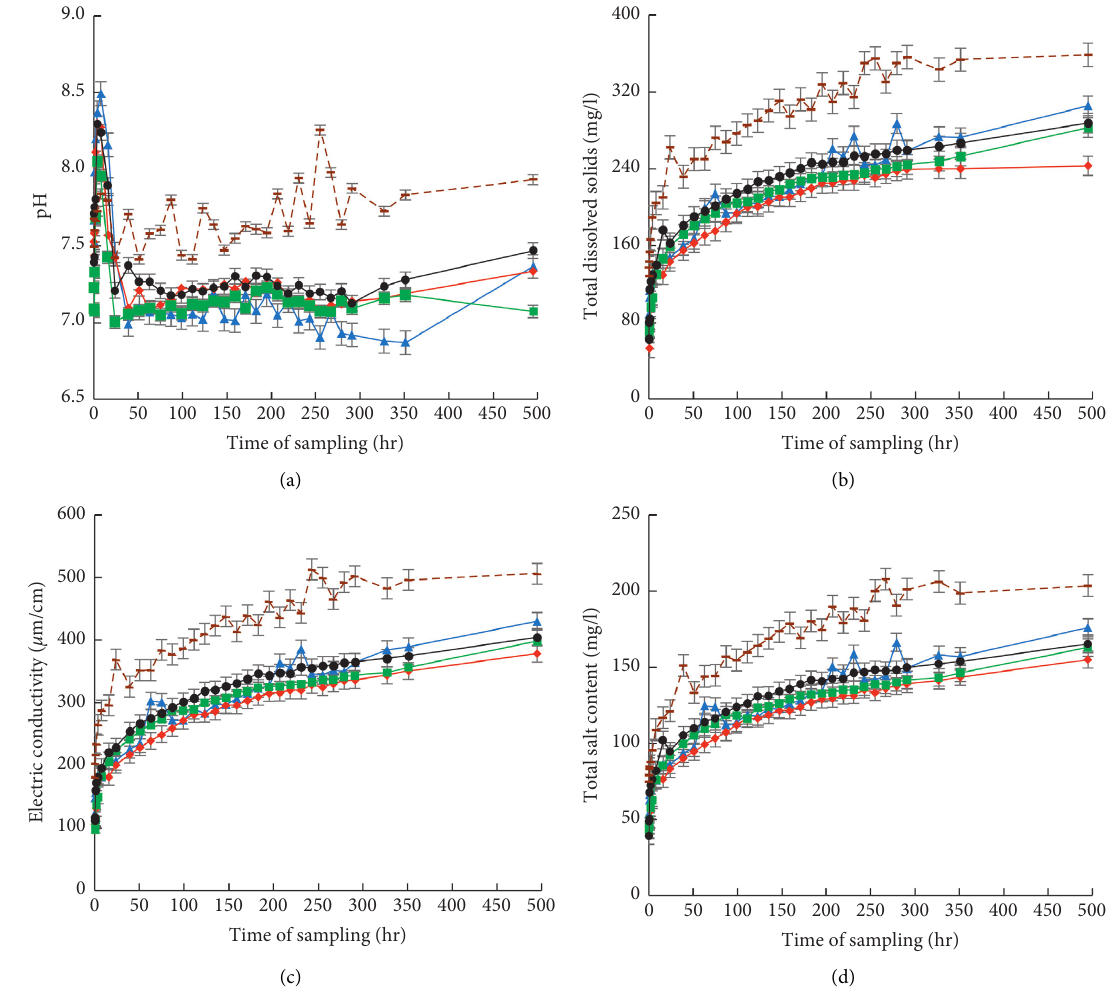
Figure 1: Changes in pH, total dissolved solids, salinity, and electric conductivity of solid vermicast-inoculated biochar (solid line, green square), vermicast tea-inoculated biochar (solid line, red rhombus), deionized water-inoculated biochar (solid line, blue triangle), biochar alone (solid line, black round), and Promix-BX alone (broken line, brown dash) in deionized water. Vertical lines represent standard error